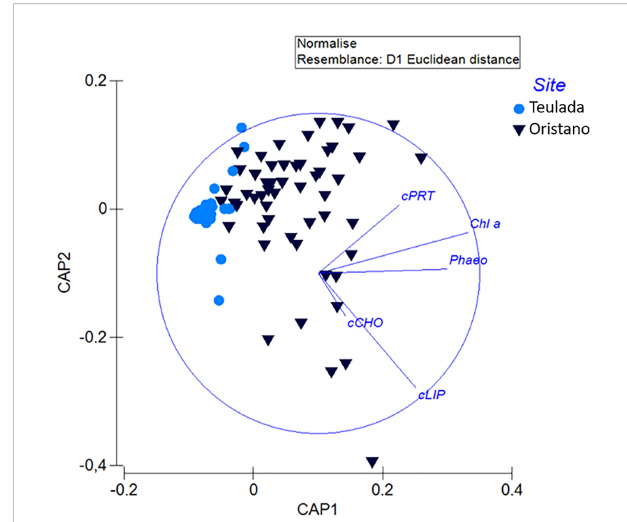
FIGURE 2 The biplot produced after canonical analysis of the principal coordinates (CAP) showing variations in the biochemical composition of sedimentary organic matter (chlorophyll: Chl a ; phaeopigments: Phaeo; and proteins: cPRT; carbohydrates: cCHO; lipids: cLIP, converted in carbon equivalent) between the organically enriched site of Oristano and the poorer site of